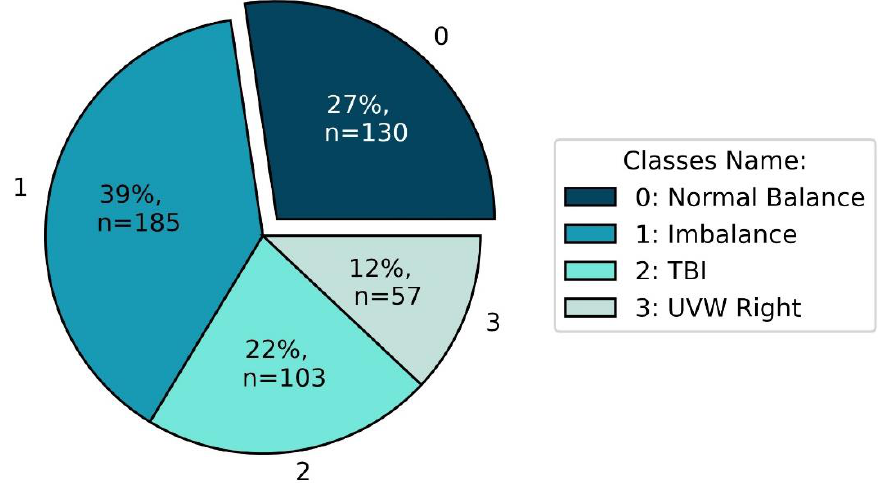
Figure 2. Percentage distribution of subjects per diagnosis.